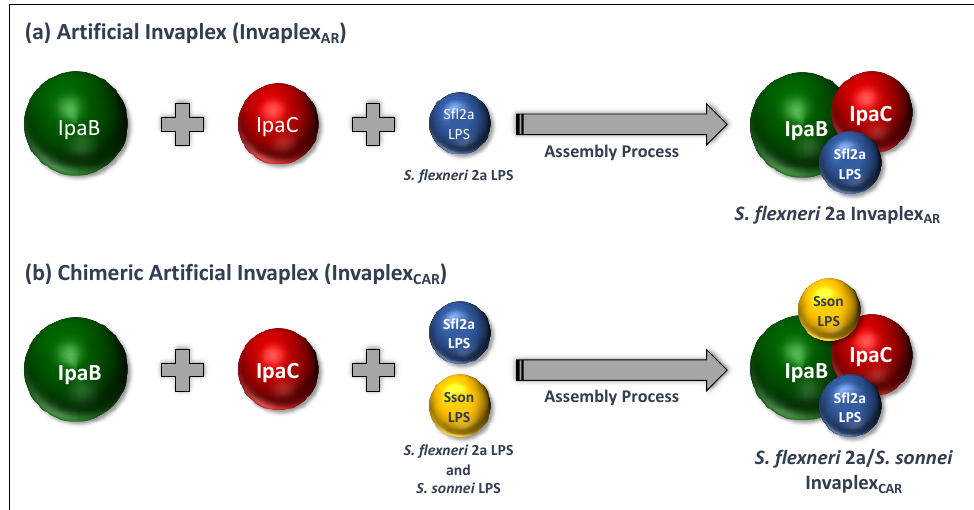
Figure 2. Assembly of artificial Invaplex and chimeric artificial Invaplex: ( a ) artificial Invaplex is assembled in a self-assembly reaction between IpaB, IpaC and LPS in a controlled manner that facilitates customization and quantities of the key immunogens contained within the complex; ( b ) multivalent Invaplex vaccines can be produced using admixtures of artificial Invaplex specific for different serotypes or manufactured as a “chimera” with LPS from multiple Shigella serotypes (example shown is a bivalent, chimeric Invaplex) with the complex containing IpaB, IpaC and LPS from more than one serotype.